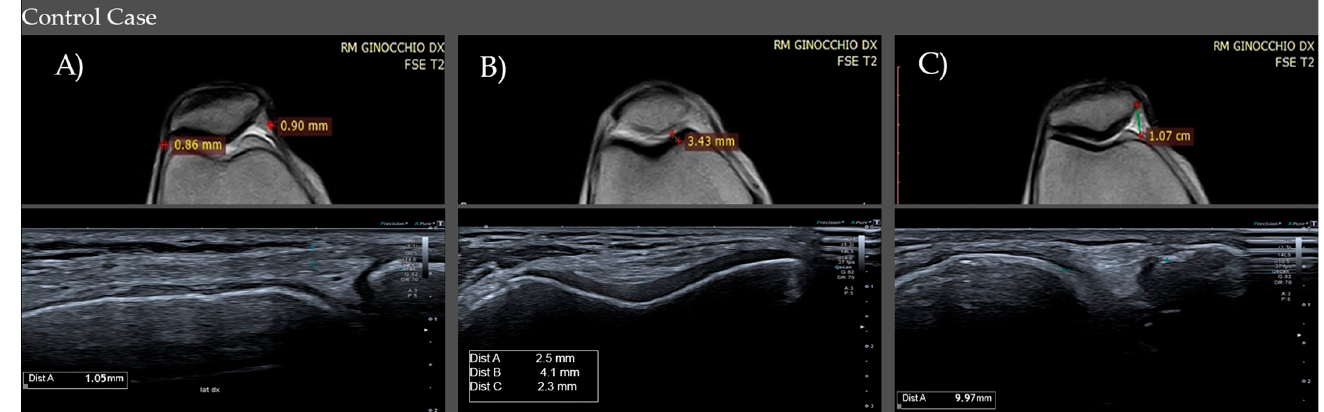
Figure 4. MRI and US values of retinacles ( A ) and cartilage ( B ) thickness and medial patello-femoral distance ( C ). Images of healthy controls.